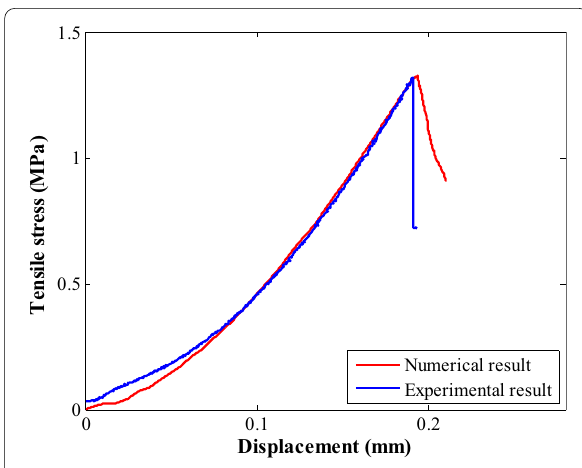
Fig. 18 Numerical and experimental result comparison when the water–cement rate was 0.42.